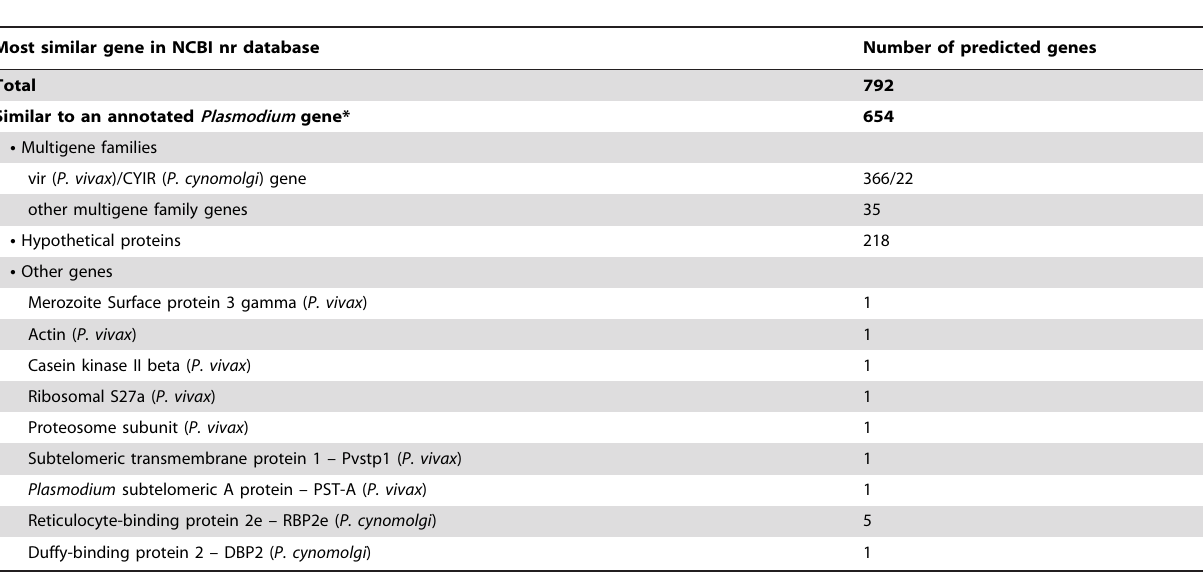
Table 2. Predicted genes in novel P. vivax DNA